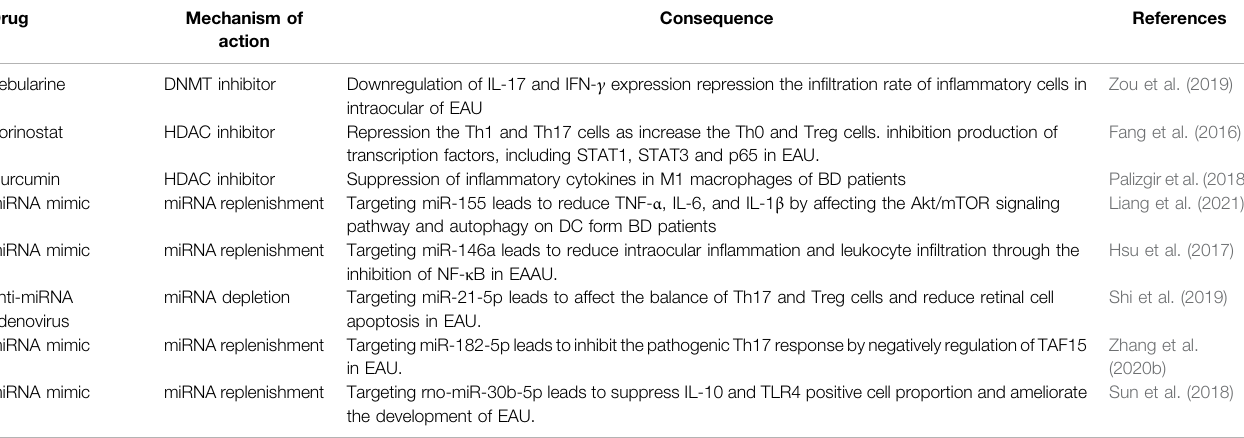
TABLE 2 | Epigenetic therapies in experiments and animal model of Uveitis.